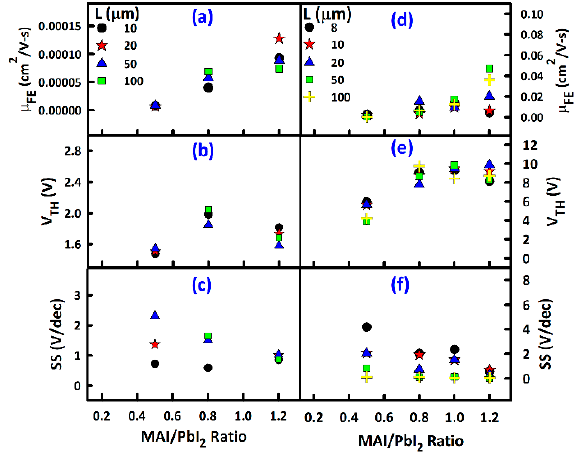
Figure 9. Extracted TFT parameters. ( a–c ) P-type and ( d–f ) n-type.